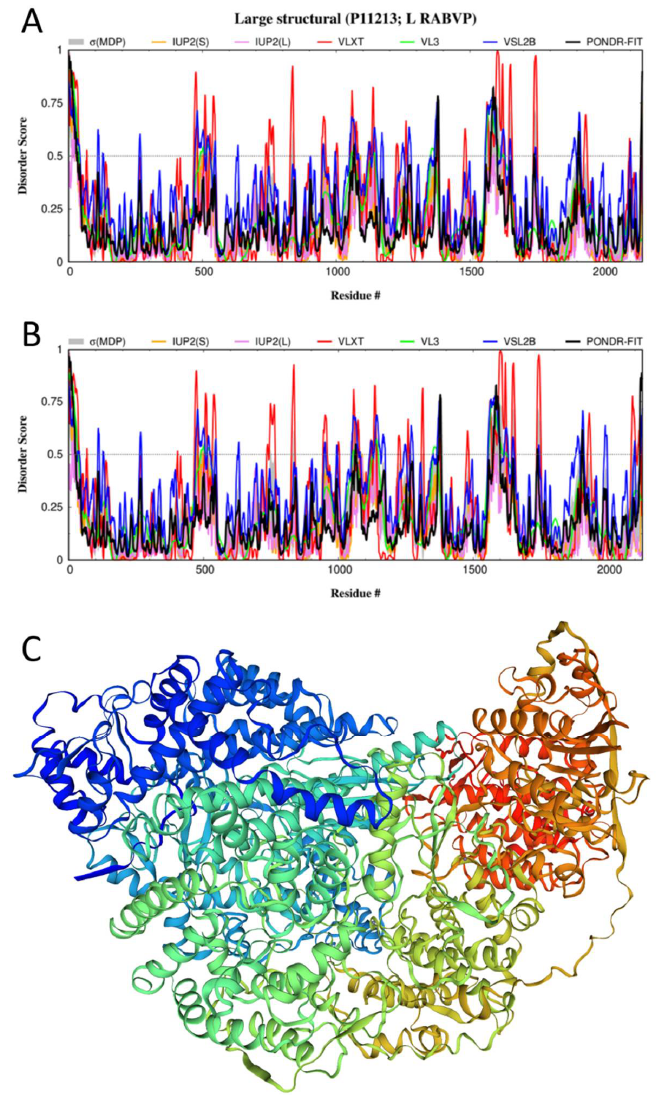
Figure 6. Structure and disorder in the L-protein from RABV. ( A ) Intrinsic disorder profile gener- ated for the L-protein from the RABV strain VP (UniProt ID: P11213) by RIDAO. ( B ) Intrinsic disor- der profile generated for the L-protein from the RABV strain SAD B19 by RIDAO (UniProt ID: P16289). ( C ) A structural model for the L-protein from the RABV strain PV built by SWISS-MODEL [97] using the cryo-EM structure of the large structural protein from the RABV strain SAD B19 (se- quence identity: 98.68%) complexed with the fragment of the P-protein (PDB ID: 6UEB, [132]; Uni- Prot ID: P16289) as a template.